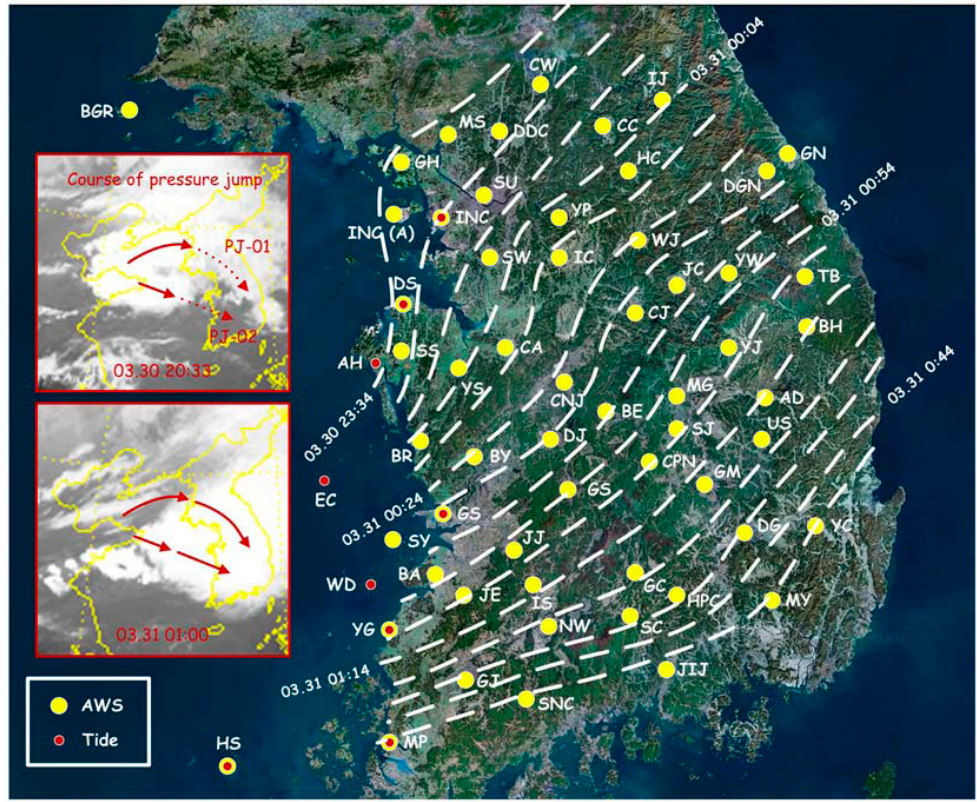
Figure 3. Distribution of pressure jump lines according to arrival time during the meteotsunami that occurred in March 2007 [7].